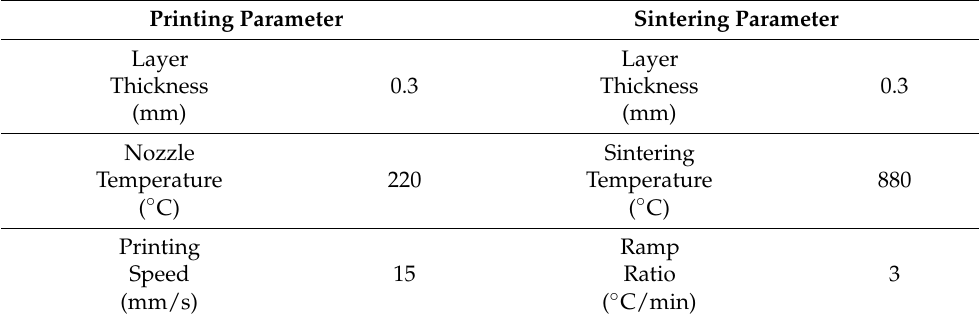
Table 8. The manufacturing parameters of verification part.